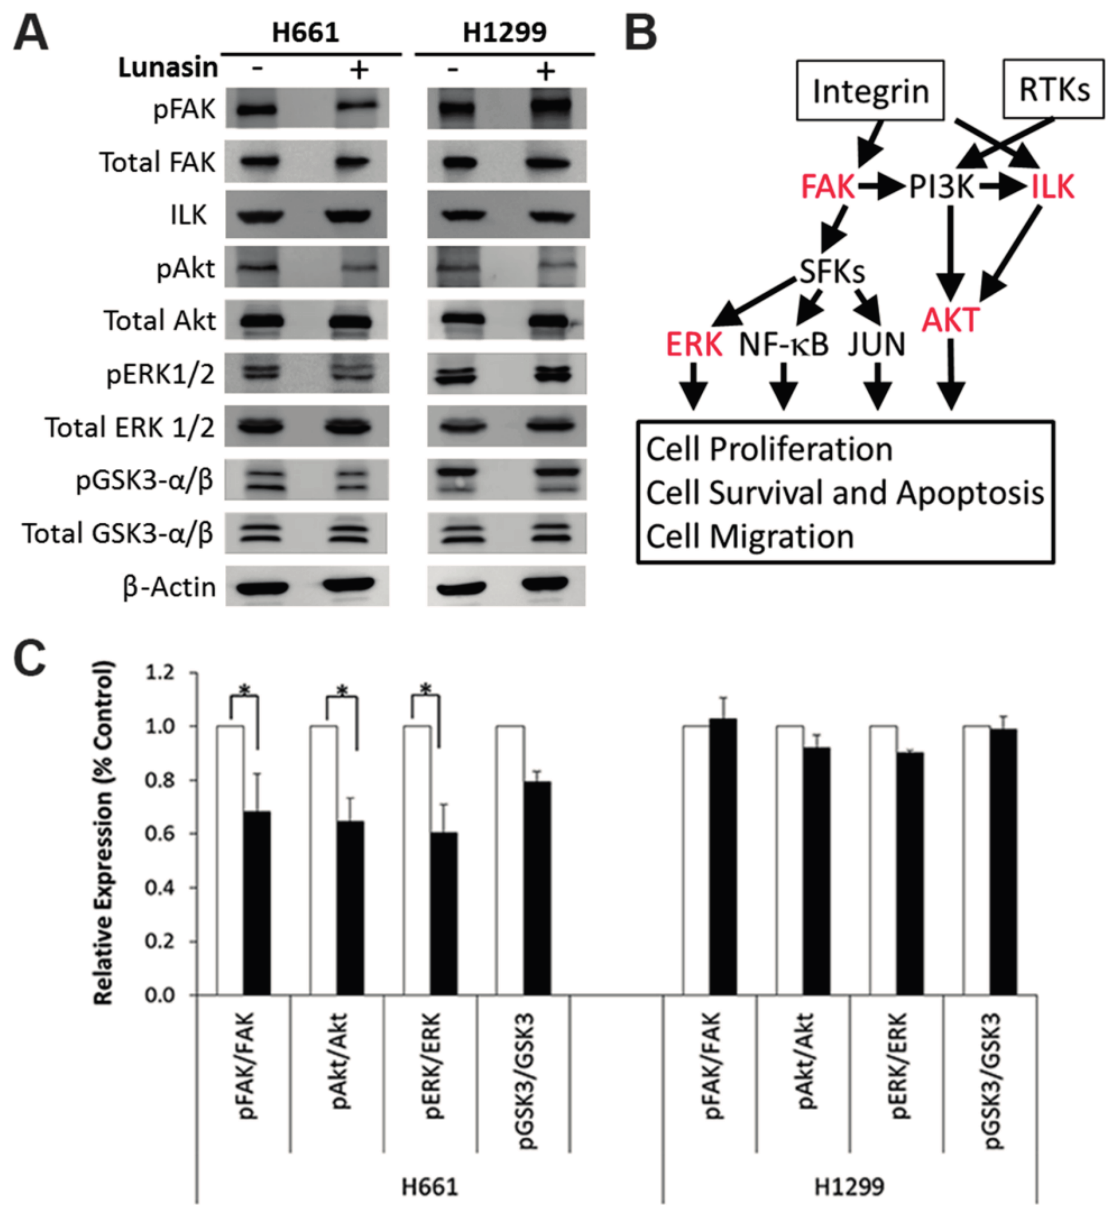
Figure 6. ( A ) Immunoblot analyses of integrin signaling pathway components in lunasin-treated NSCLC cells. Analyses were repeated in three independent experiments and representative data from one experiment is shown; ( B ) Integrin signaling pathway showing effects of lunasin treatment in H661 cells. RTKs, Receptor Tyrosine Kinases; SFKs, Src Family Kinases. Proteins shown in red indicate signaling steps negatively affected specifically in H661 cells by lunasin treatment; ( C ) Relative expression levels of integrin signaling proteins. Immunoblots shown in ( A ) were analyzed using ImageJ software v1.45 (National Institutes of Health, Bethesda, MD, USA). Data represent the mean ± SD for three independent experiments. The asterisk (*) indicates a significant ( p < 0.05) difference in expression levels relative to the vehicle